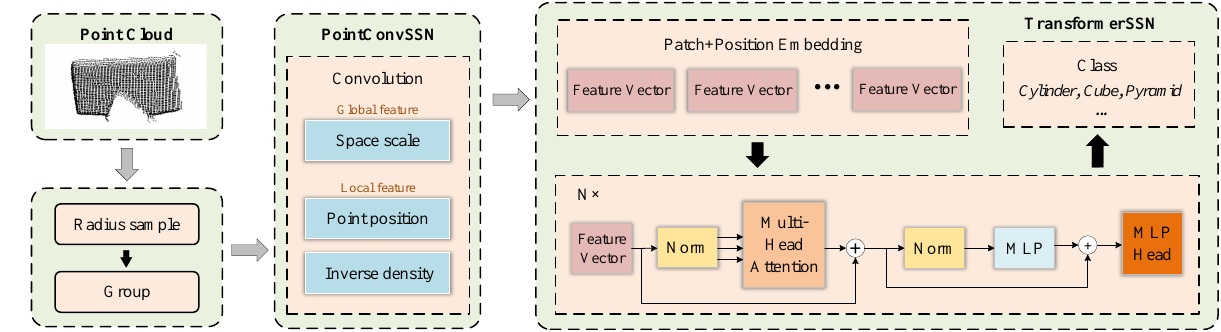
Figure 3. Structure of the Stacked Object Classification Network (SOCN). The segmented point clouds enter PointConvSSN after radius sampling and grouping. Then, the feature vectors obtained by 3D convolution are sent to TransformerSSN for extraction of more semantic information, and finally the object classification is obtained.